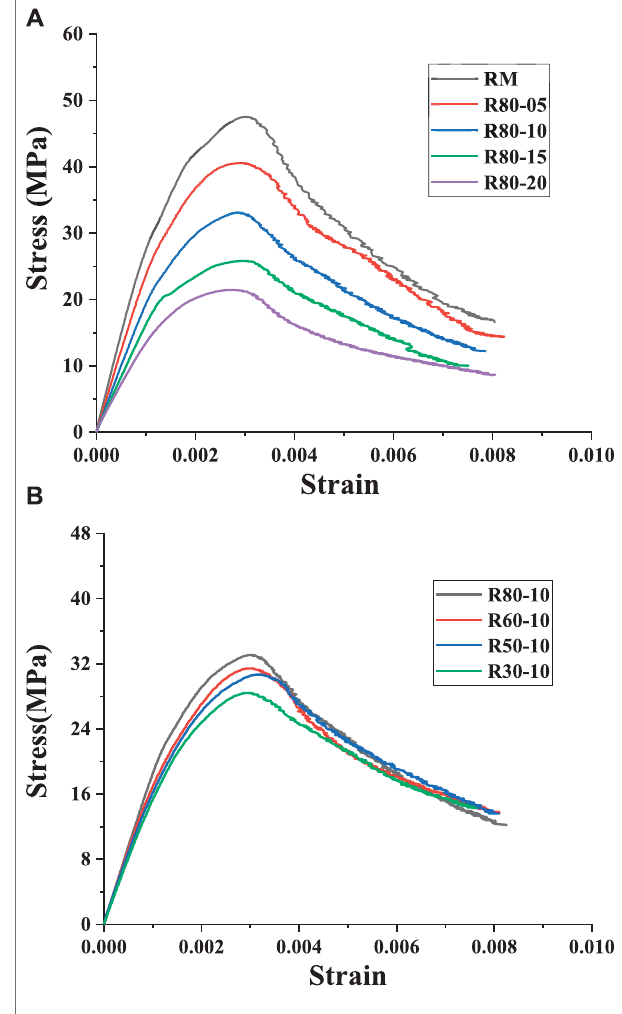
FIGURE 6 | Static stress-strain curves of the mortar